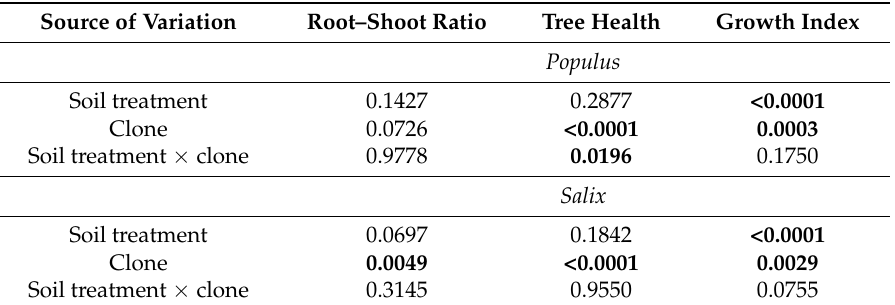
Table 3. Probability values from analyses of variance in a study assessing the relationships among root–shoot allocations, early growth, and health of hybrid poplar and willow clones when grown for 65 days in soils from five landfills in eastern Wisconsin,